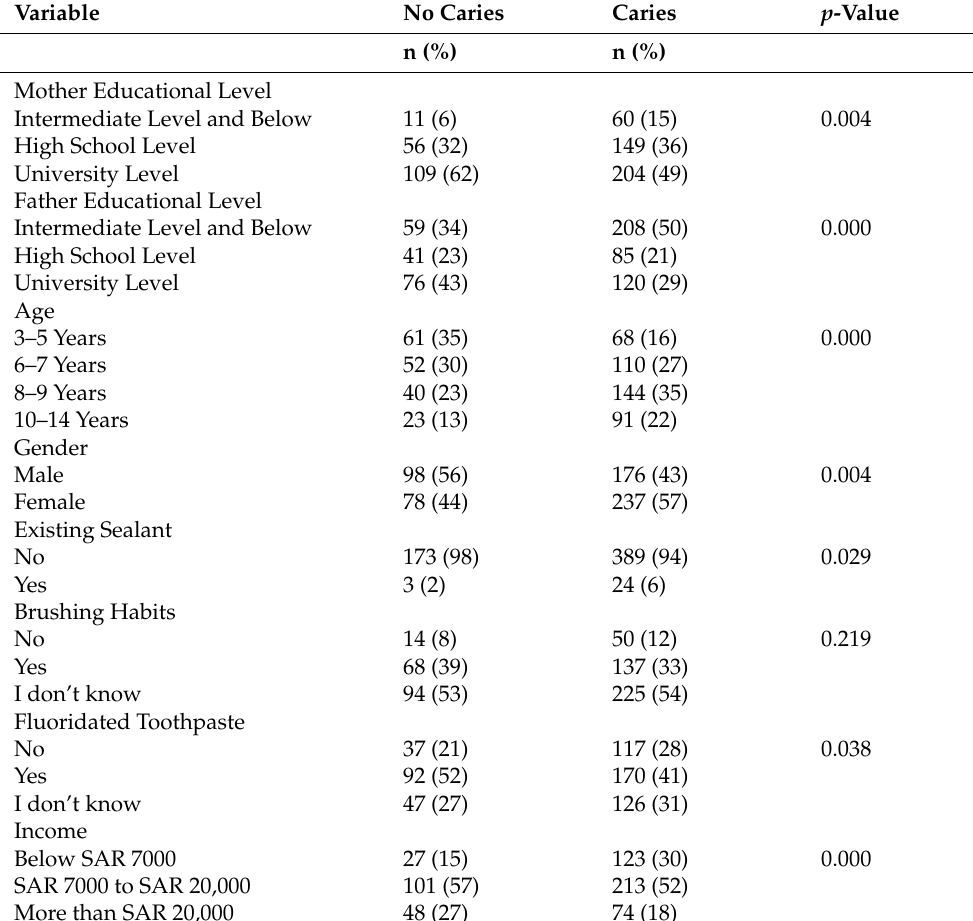
Table 2. Comparisons of caries with demographical